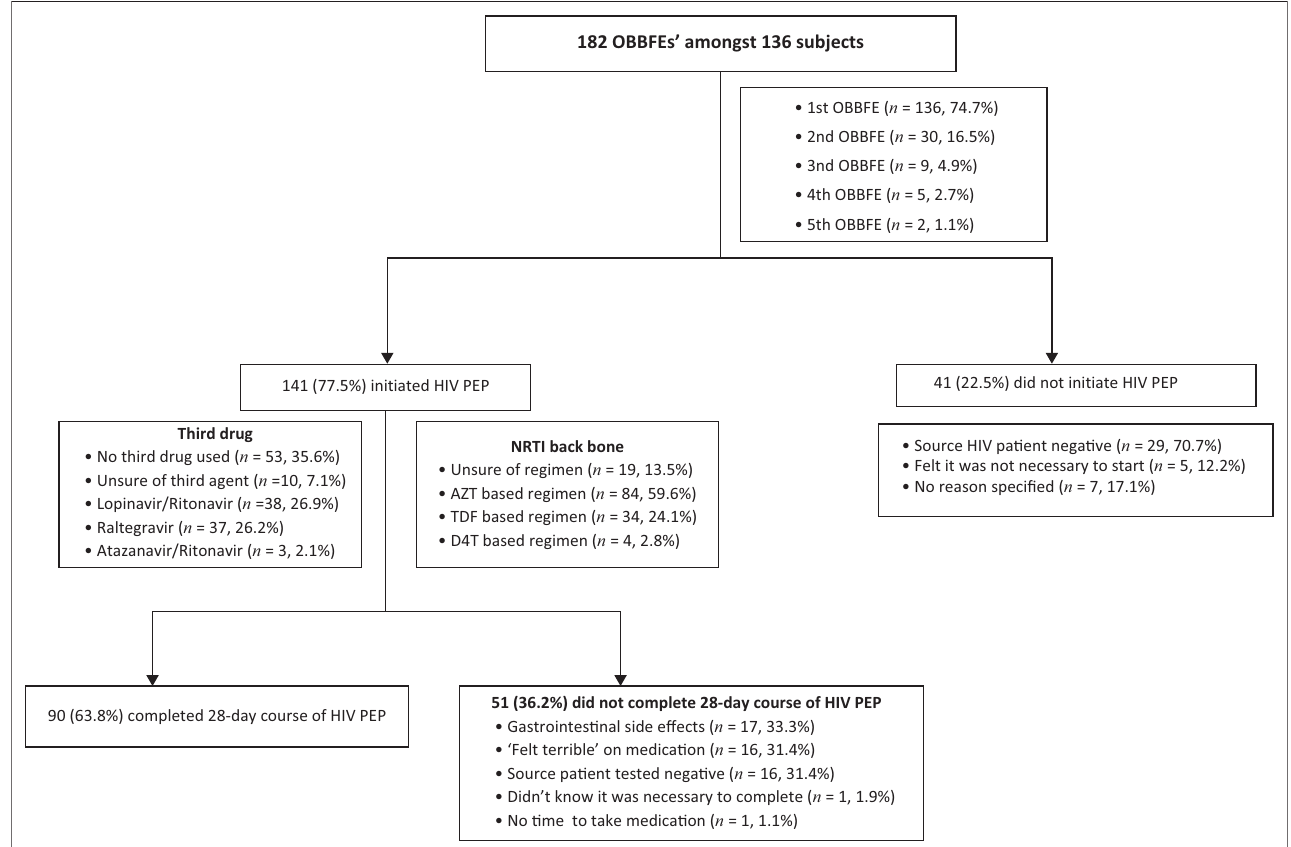
FIG URE 1: Initiation, compliance and regimen pertaining to HIV post-exposure prophylaxis amongst study